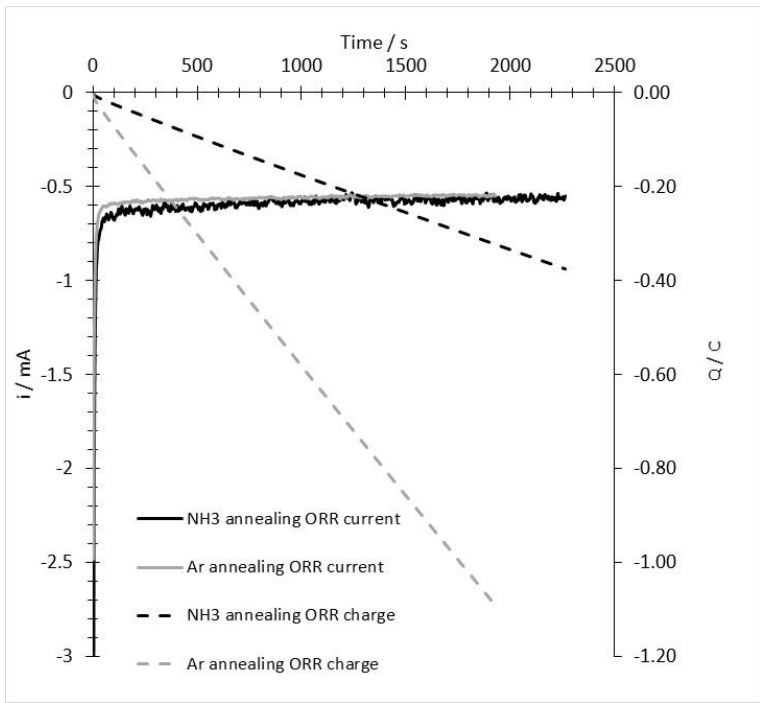
Figure A2. Examples of ORR chronoamperometry measurements (and corresponding charge) performed on an NH 3 annealed electrode sample (black lines) and an Ar annealed electrode sample (grey lines). The loading for the NH 3 annealed electrodes sample is 2.29 mg·cm −2 , and the loading for the Ar annealed electrode sample is 3.82 mg·cm −2 . The selectivities calculated for both of the electrodes are shown in Figure 6.